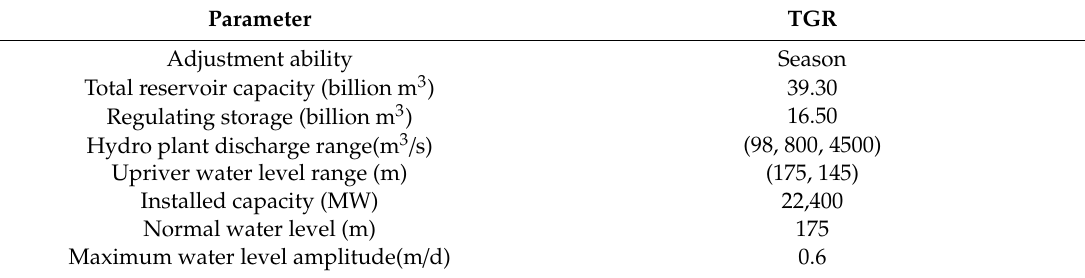
Figure 4. The location of the research area in China. Table 1. Main parameters of the Three Gorges Reservoir (TGR).